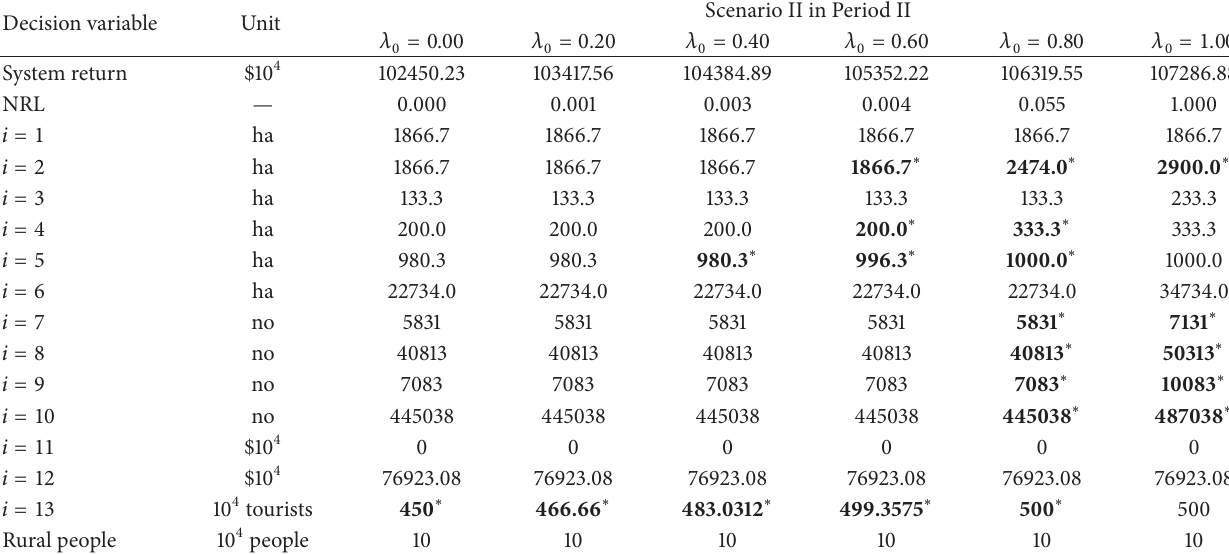
Table 5: Risk explicit analysis in Period II under Scenario